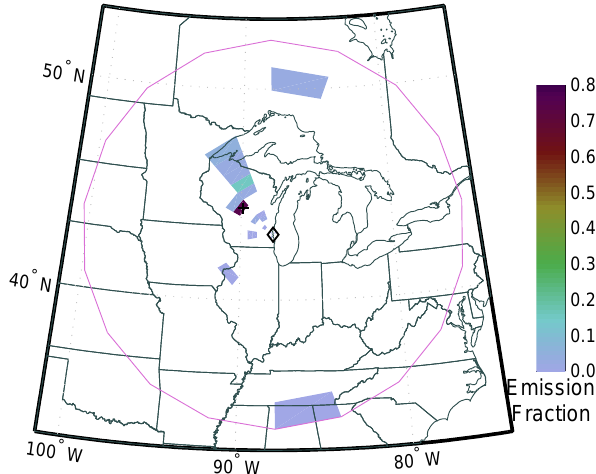
Fig. 7. Map of emissions from the inverse model using synthetic simulations from a location ( + ) 213 km northwest of the receptor site (diamond). Units are fraction of the synthetic release. Extent of the back-trajectory grid used for the inversion shown in pink. Areas with zero emissions shown in white.